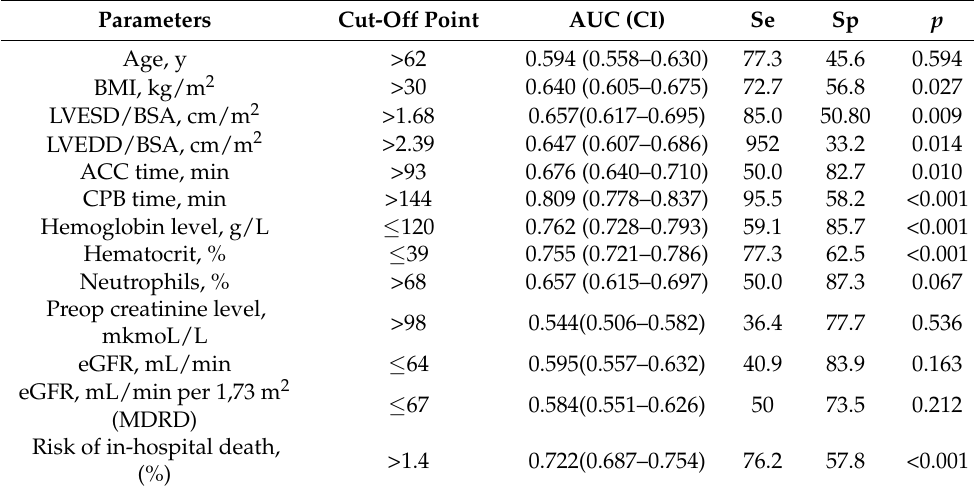
Table 4. The results of ROC analysis for the initial quantitative clinical, instrumental and laboratory parameters, associated with mortality.